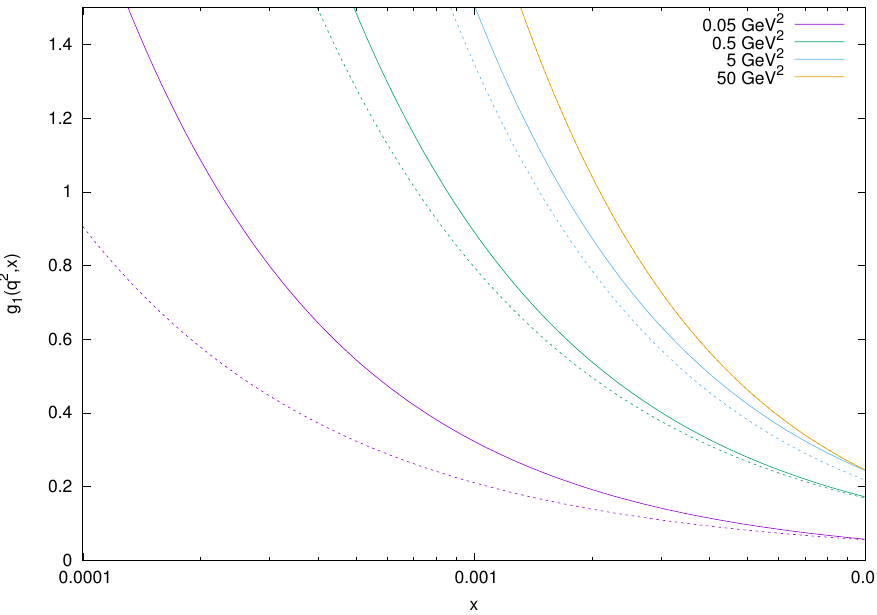
Figure 8. Our results for the structure function g 1 . Solid lines correspond to the conformal model. Dotted lines correspond to the hard-wall model. The values of the photon virtuality q 2 are